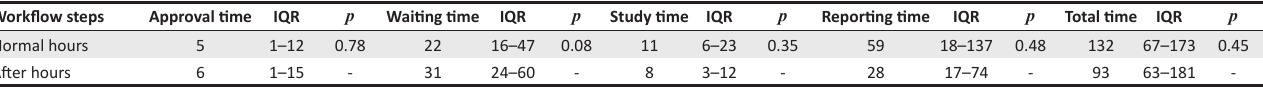
TABLE 5: Time parameters. Workflow steps